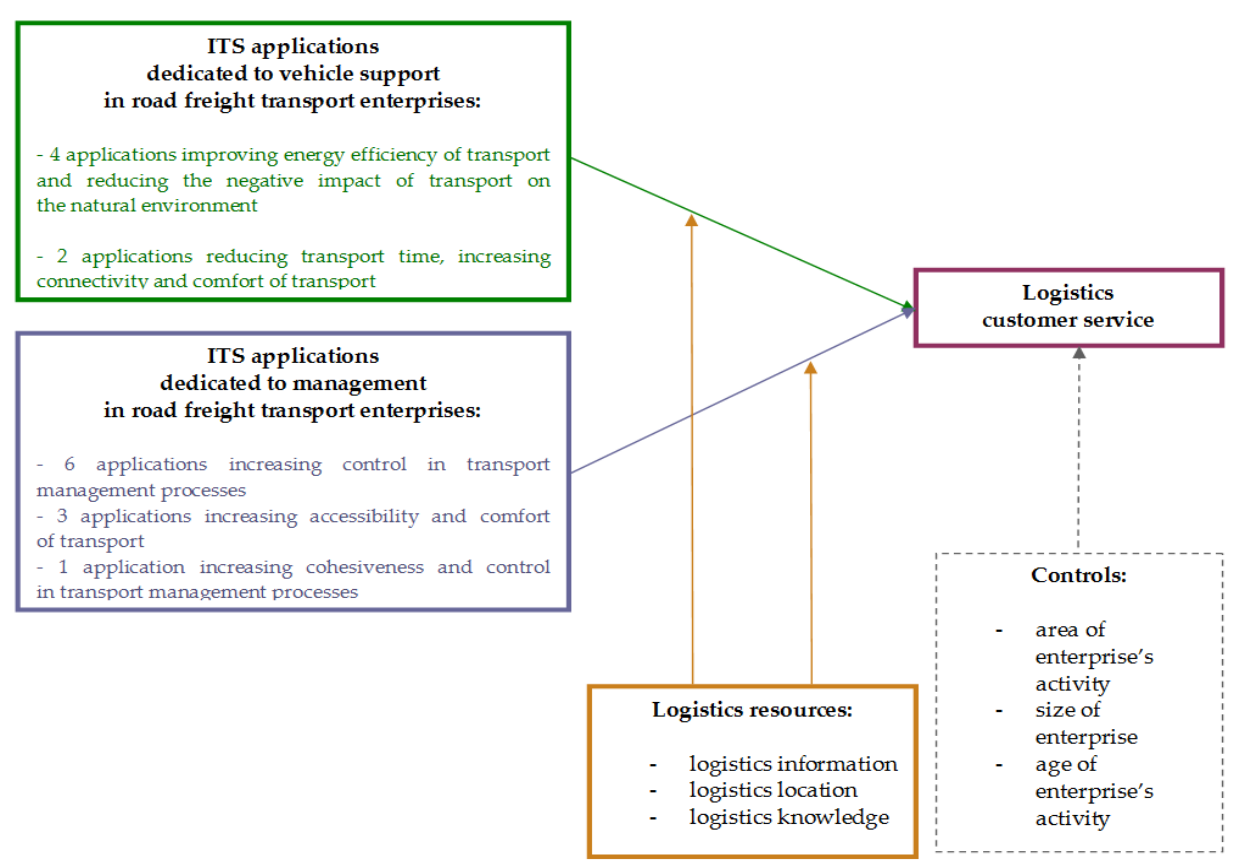
Figure 2. Conceptual model. Source: own elaboration.